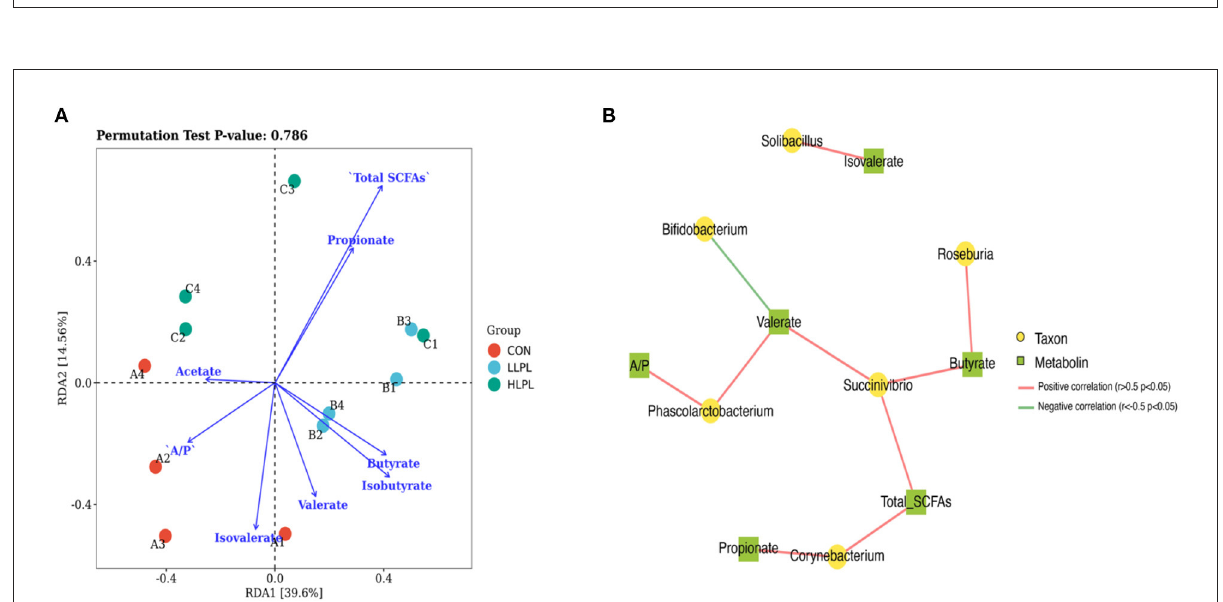
FIGURE3 Association and model predictive analysis. (A) RDA analysis of the correlation between the microbiota and their metabolites. Each point represents a sample; each arrow represents a metabolite (SCFAs). (B) Co-occurrence network analysis among the microbiota and metabolites. Each co-occurring pair among microbial populations at the genus level and their metabolites has an absolute Spearman rank correlation above 0.5 [red line, positive correlation ( r ≥ 0.5); green line, negative correlation ( r ≤ − 0.5)] with a FDR-corrected significance level under 0.05.